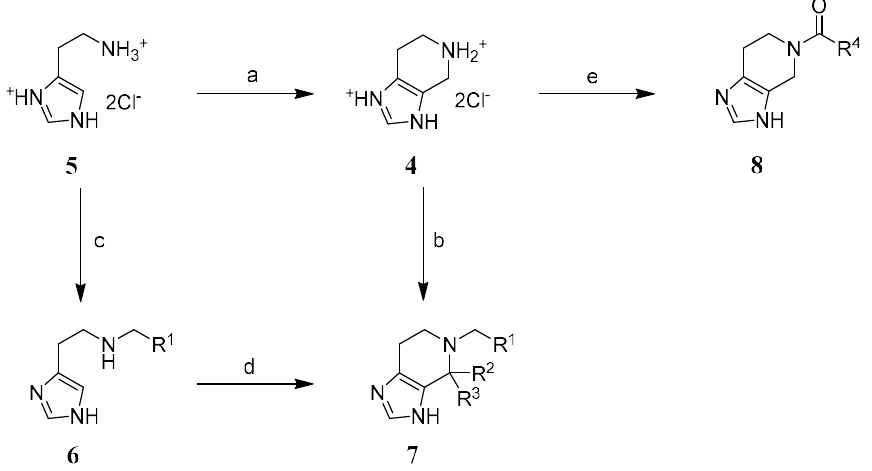
Figure 4. Synthesis of tetrahydroimidazo[4,5- c ]pyridine derivatives.